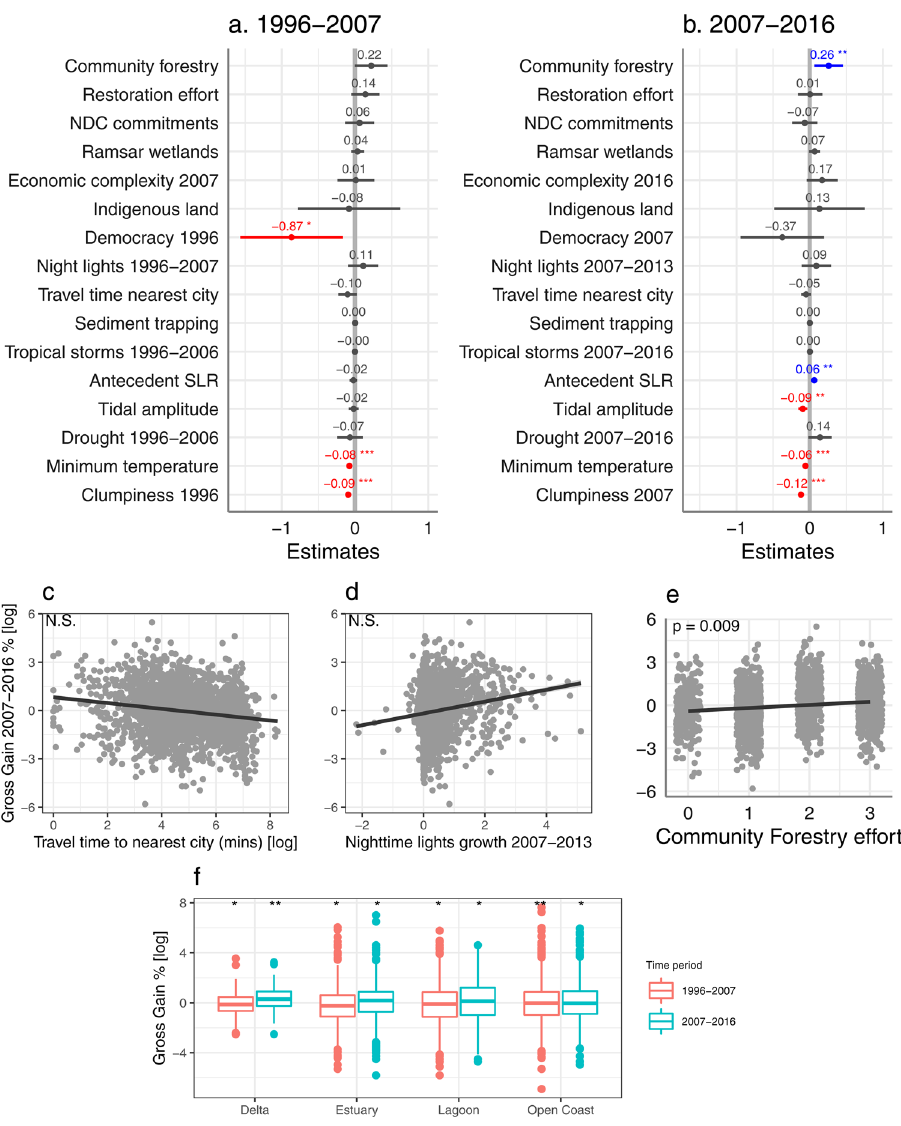
Fig. 6 | Global drivers of mangrove gross gain. Fixed effects of socioeconomic and biophysical variables on percent gross gain of mangrove cover in 1996 – 2007 ( a ; n =2341mangrovegeomorphicunitsacross55countries)and2007 – 2016( b ; n = 2554 mangrove geomorphic units across 59 countries) showing the estimate and 95% con fi dence intervals from the mixed-effects models. Positive values (in blue) indicate mangrove gain increased with an increase in the variable, while negative values (in red) indicate mangrove gain decreased with an increase in the variable. NDCNationally Determined Contribution. SLR sea-levelrise. Relationshipbetween percent gross gain 2007 – 2016 and travel time to nearest city ( c ), night-time lights